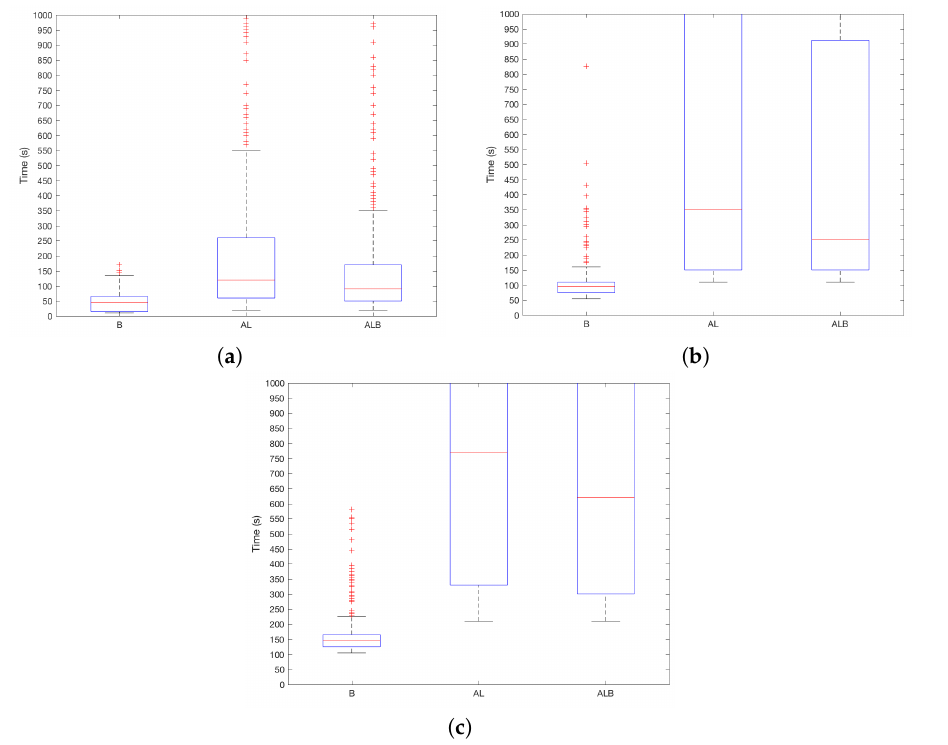
Figure 4. T SEC results depending on the chosen sensors. ( a ) ST = 1; ( b ) ST = 10; ( c ) ST = 20.